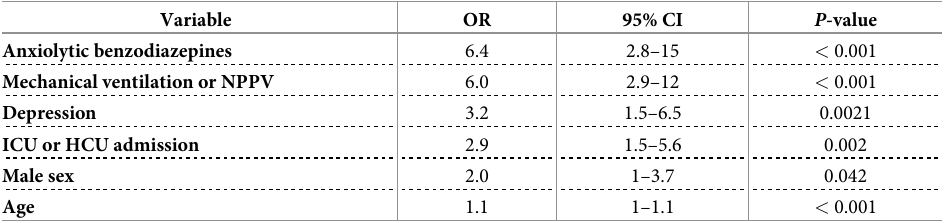
CI, confidence interval; HCU, high care unit; ICU, intensive care unit; NPPV, noninvasive positive pressure ventilation; OR, odds